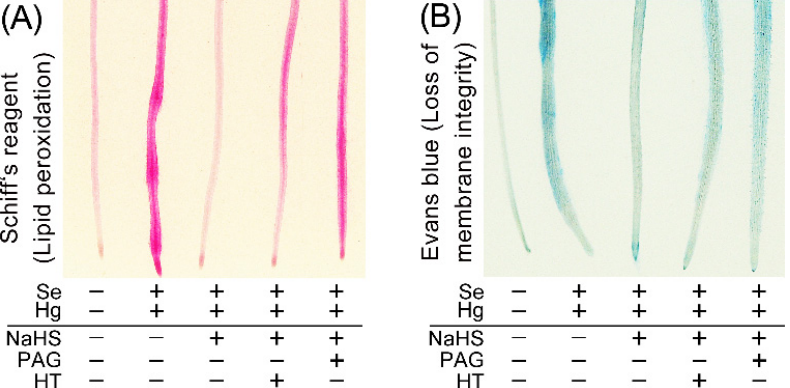
Figure 5. Endogenous H 2 S is involved in alleviating oxidative injury in the roots of B. rapa seedlings upon Hg + Se stress. ( A ) In vivo detection of lipid peroxidation in roots. ( B ) In vivo detection of loss of membrane integrity in roots.